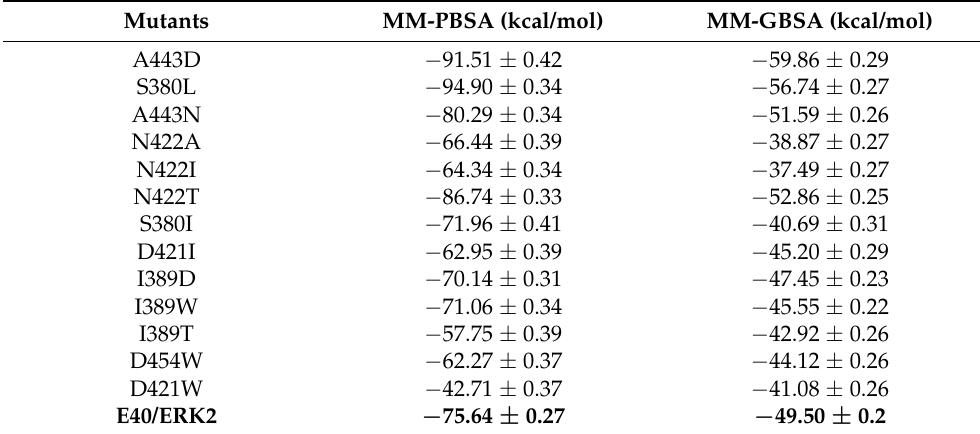
Table 2. Comparison of the binding free energy ( ± SEM) of mutants obtained by the MM- PBSA/GBSA